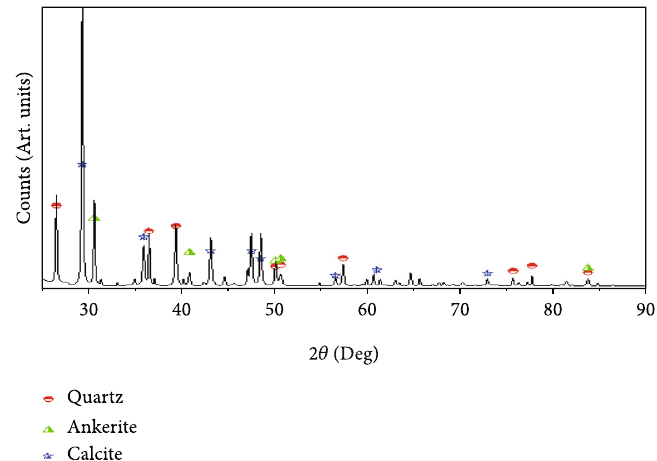
Figure 1: X-ray di ff raction patterns of ND.